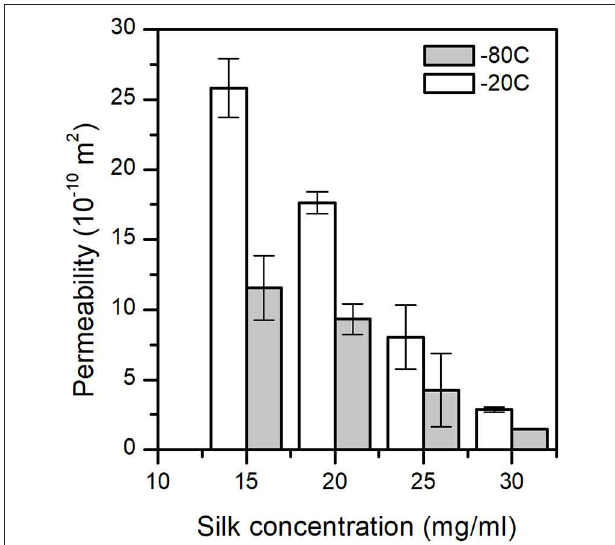
FIGURE 6 | Sponge scaffolds’ permeability ( n = 3) at different process temperatures and silk concentrations.